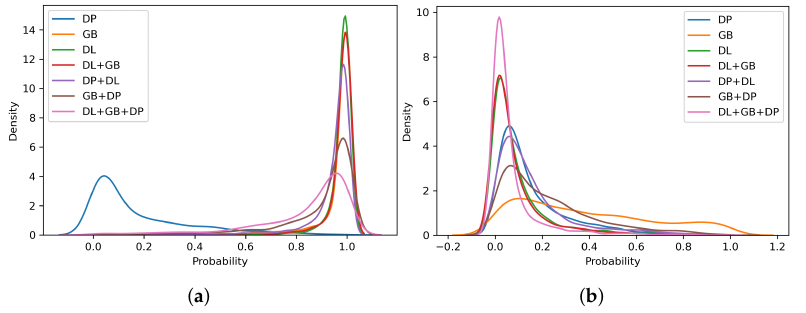
Figure 12. Probability distributions of ( a ) real and ( b ) fake fingerprint scores of the Dermalog consensual dataset obtained by the PAD